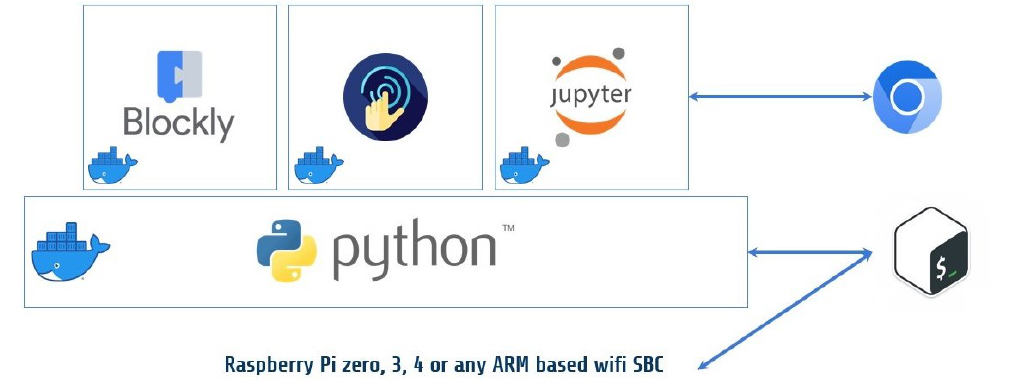
Figure 3. The software